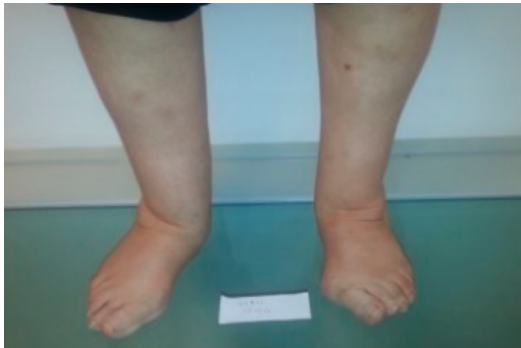
Figure 1. Rheumatoid arthritis feet deformities inspected in the standing position: Hallux abducttus valgus, flatfeet and fibular deviation of metatarsophalangeal joints are observed. Foot posture index evaluation in the anterior view.